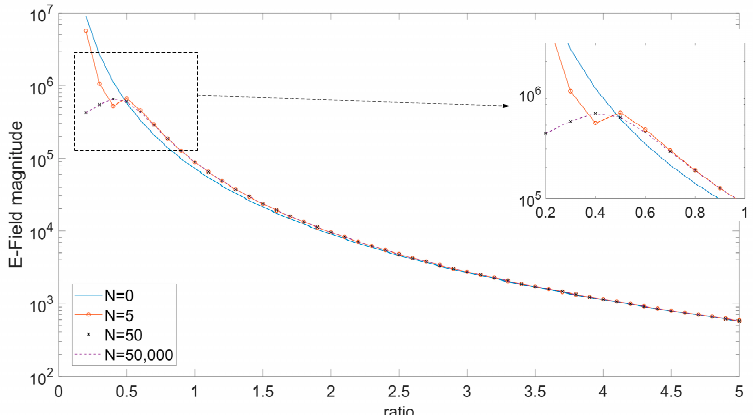
Figure 3. Comparison of the magnitude of the electric field ( E x2 + E y2 + E z2 ) 1/2 versus the ratio of the measurement distance to the cable length, for N = 0 (straight blue line), 5 (bulleted red line), 50 (x marks), and 50,000 (dashed line) segments.